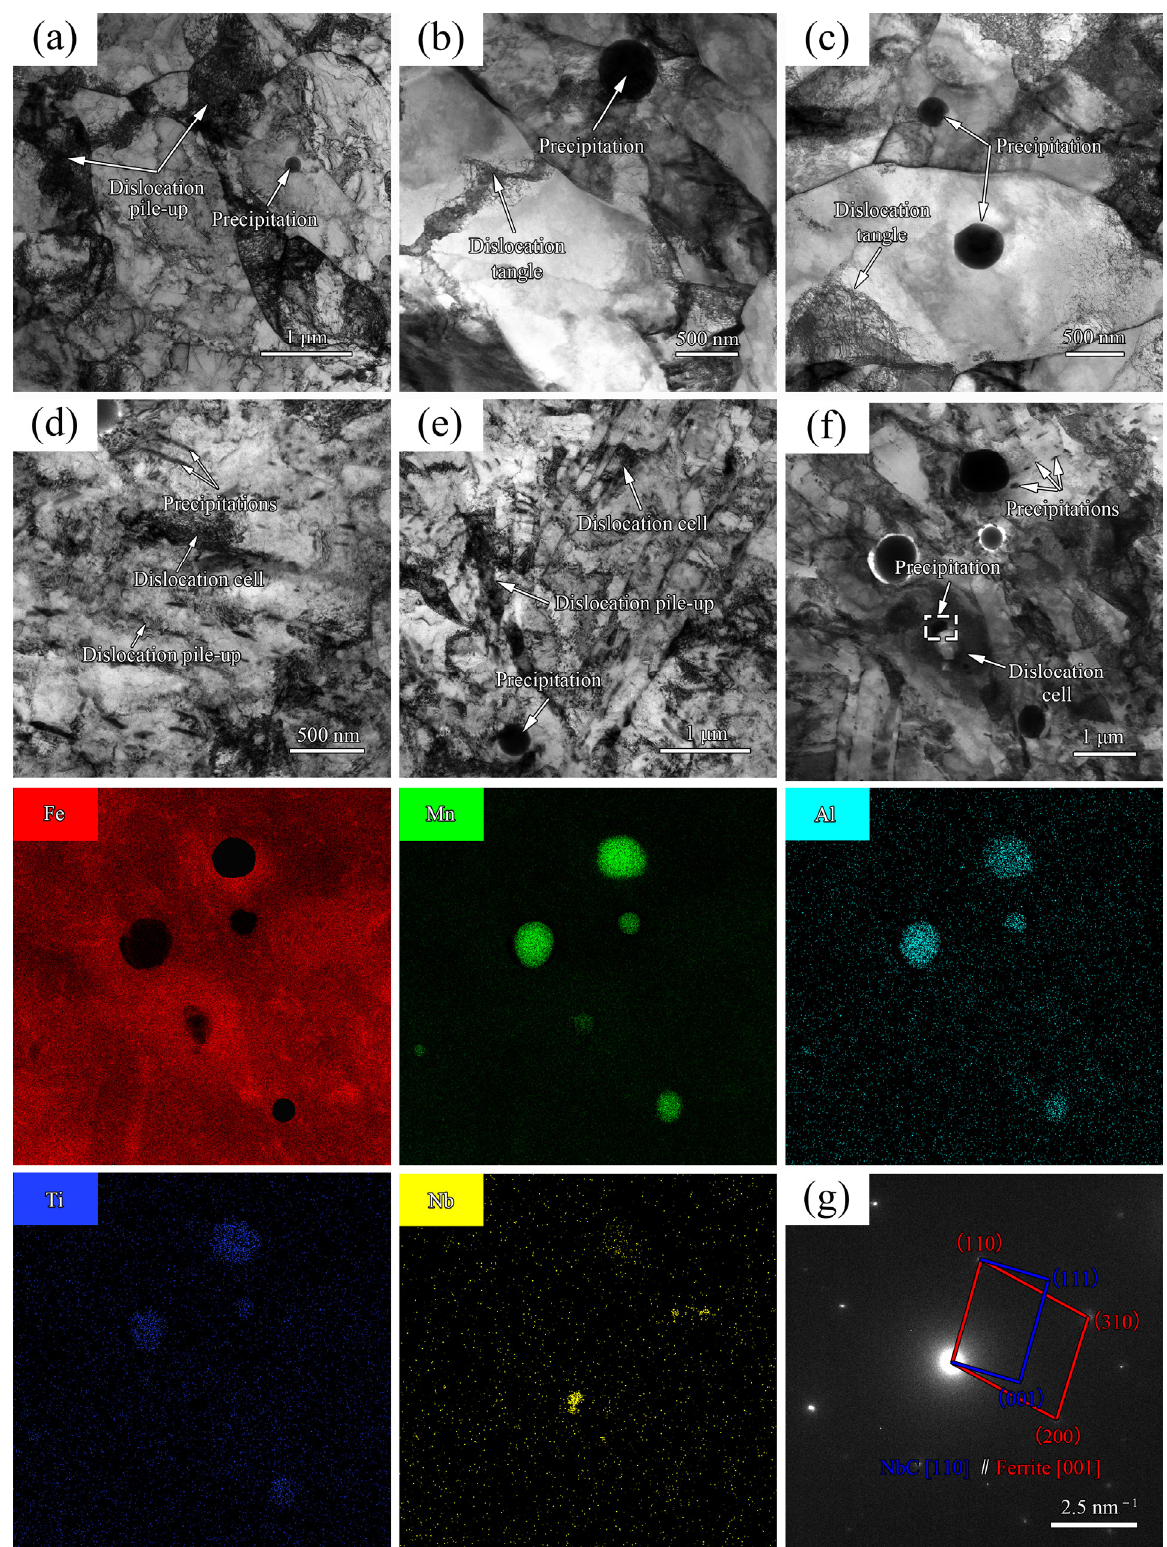
Figure 14. Morphology of precipitations and dislocations in the CPF zone of LSM-CPF process for 2000 W treatment: ( a ) dislocation pile-up of sample 3; ( b ) dislocation tangle of sample 3; ( c ) precipitations of sample 3; ( d ) dislocation pile-up of sample 4; ( e ) dislocation cell of sample 4; ( f ) precipitations and elements distribution of sample 4; and ( g ) SAED pattern of the precipitation.